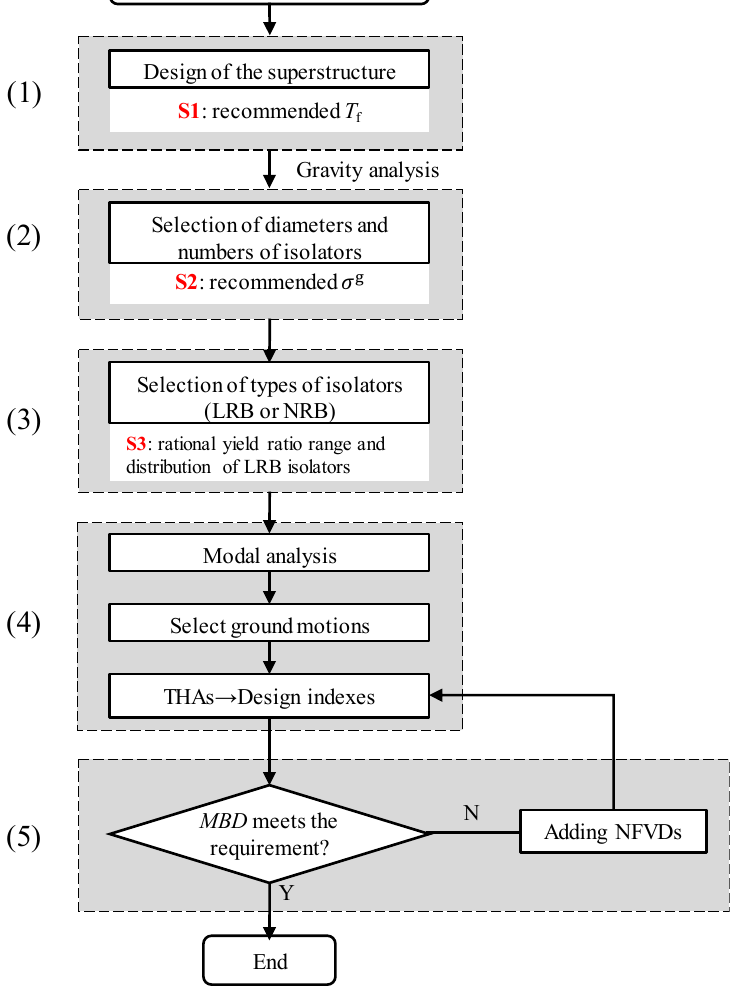
Figure 10. Proposed high-efficiency design method for seismically isolated tall building based on rational range of yield ratios. (S1~S3 denote the solutions to the critical problems)